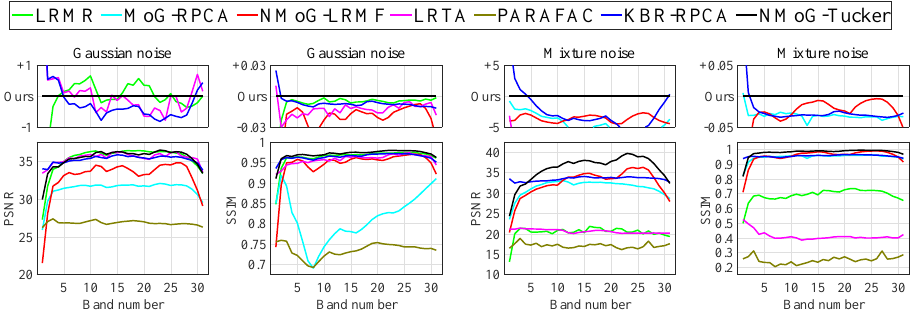
Figure 2. PSNR and SSIM values of each band in MSI denoising, averaged over six testing MSIs. Differences between our results and the competing ones are plotted at larger